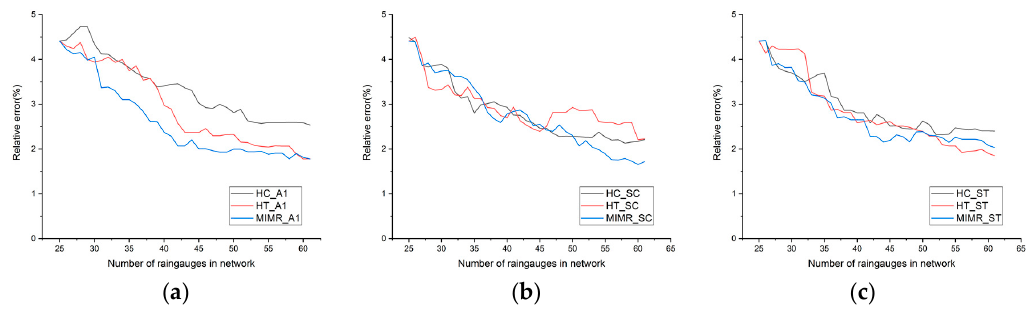
Figure 8. Comparison of the relative errors of the networks. ( a ) Statistical results of three networks based on the A1 discrete method; ( b ) Statistical results of three networks based on the SC discrete method; ( c ) Statistical results of three networks based on the ST discrete method.